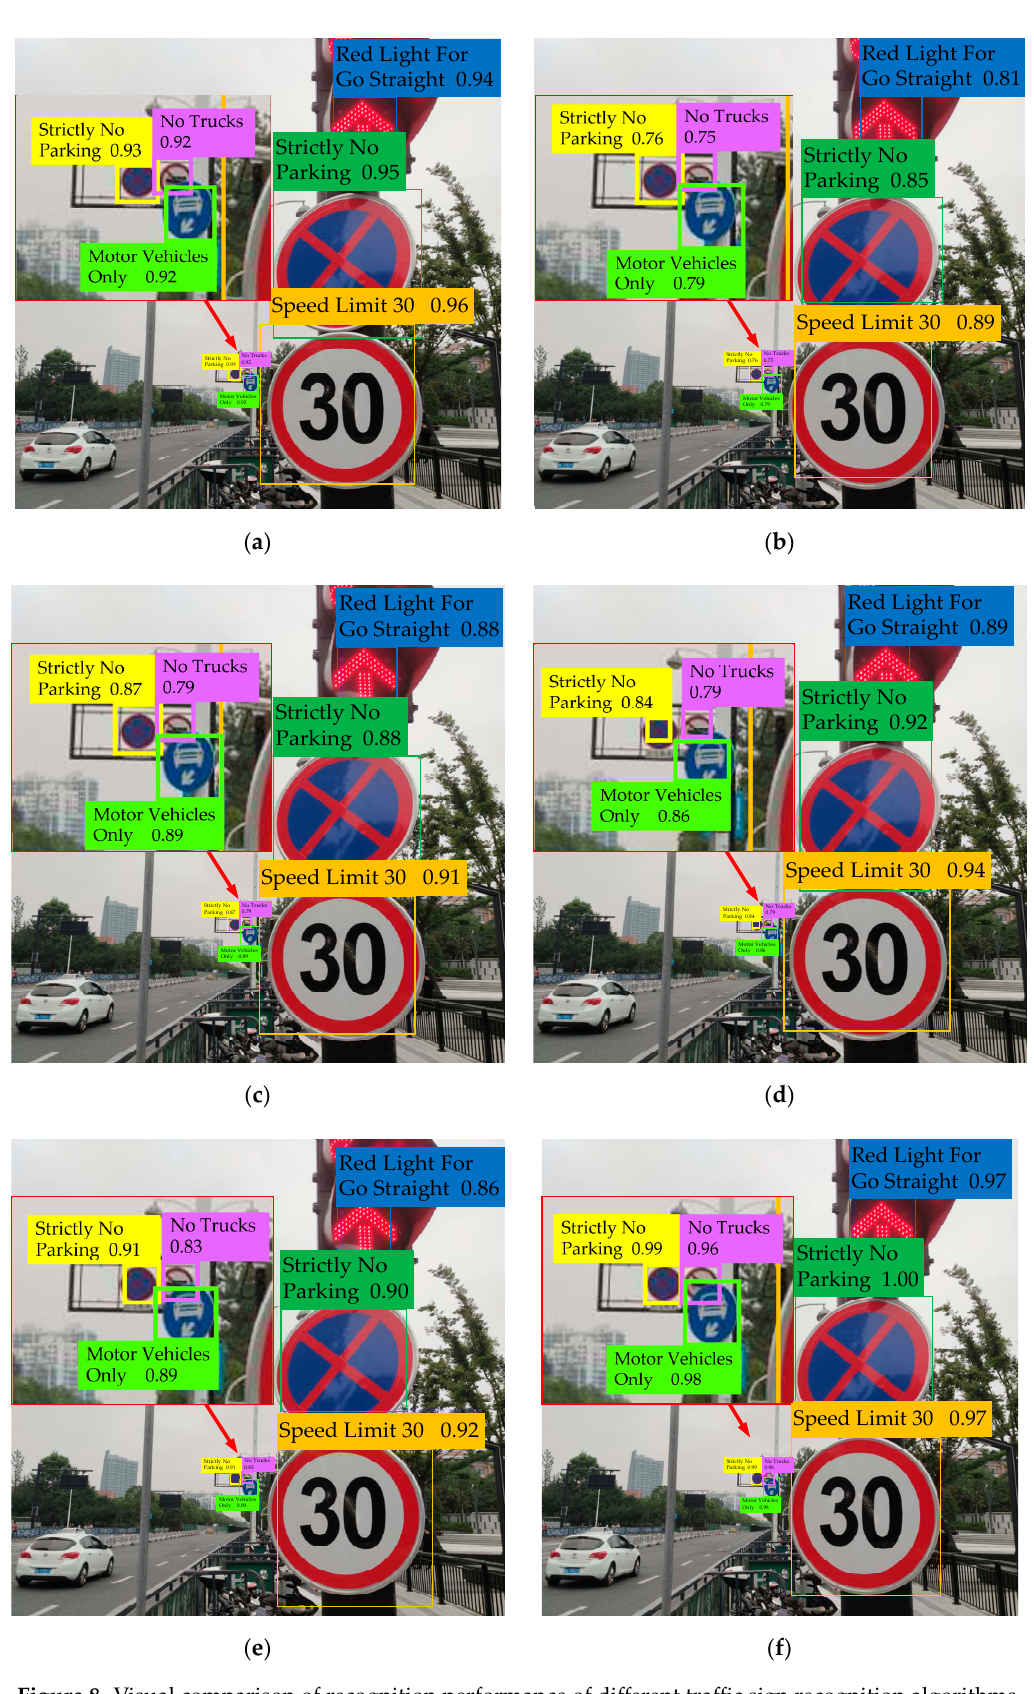
Figure 8. Visual comparison of recognition performance of di ff erent tra ffi c sign recognition algorithms for the same image. ( a – f ) are the recognition results of the tra ffi c sign recognition algorithms based on modified Faster R-CNN [9], modified SSD [23], modified RefineDet [26], modified RetinaNet101 [39] (its backbone is ResNet-101), modified YOLOv3 [10] and the proposed